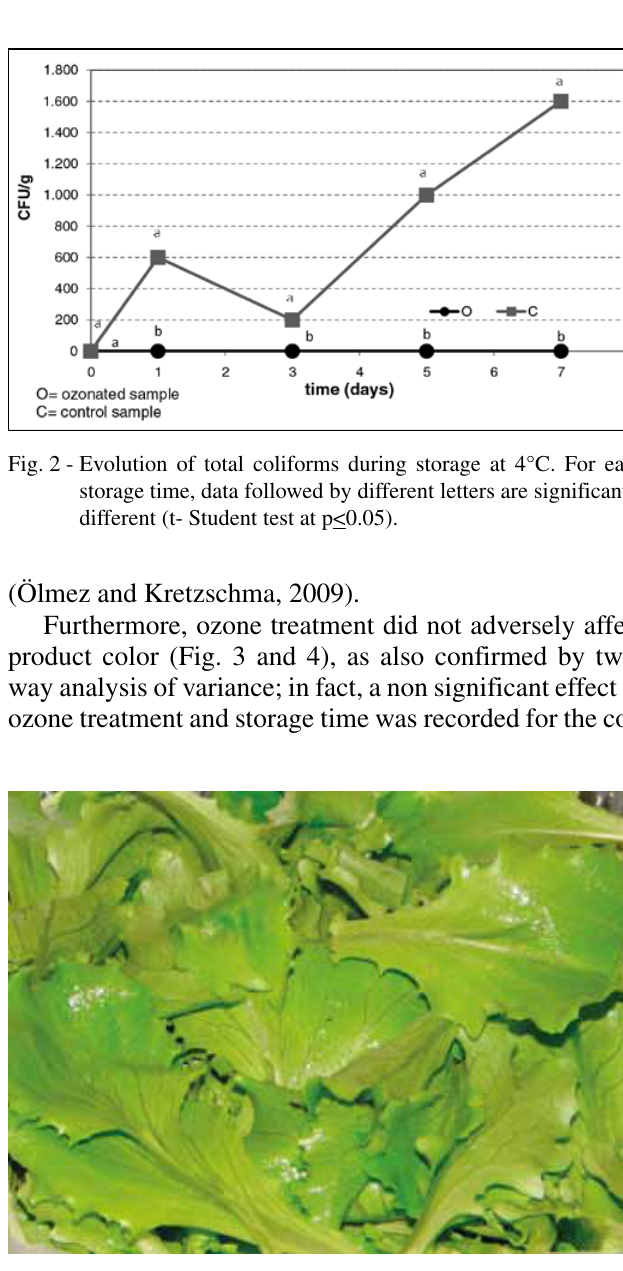
Fig. 3 - Lettuce not treated with ozone after 3 days of storage at 4°C.